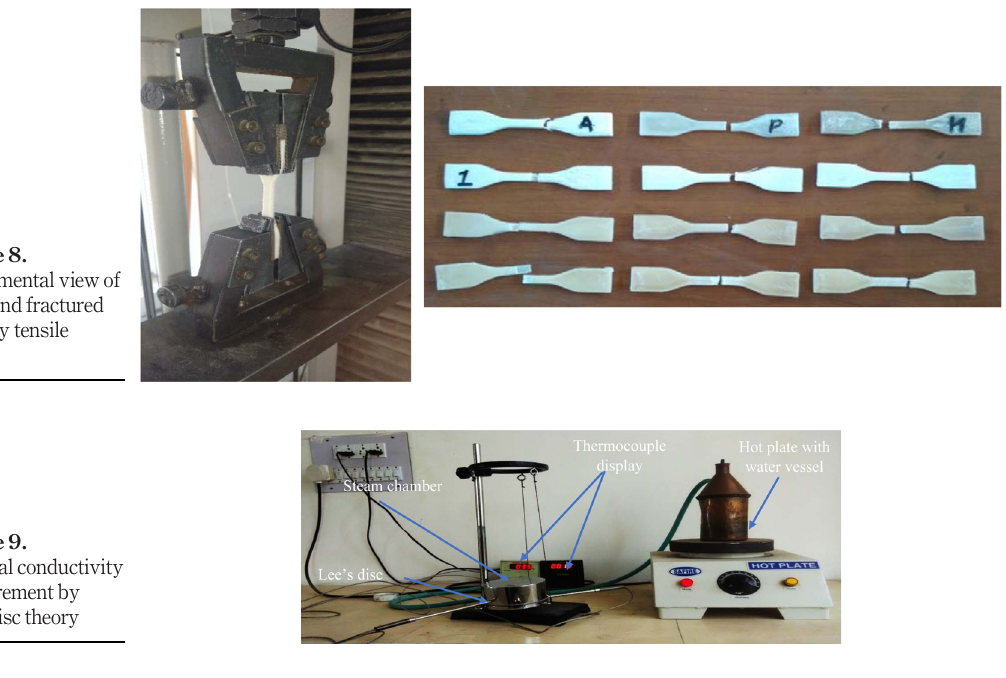
Figure 9. Thermal conductivity measurement by Lee ’ s disc theory